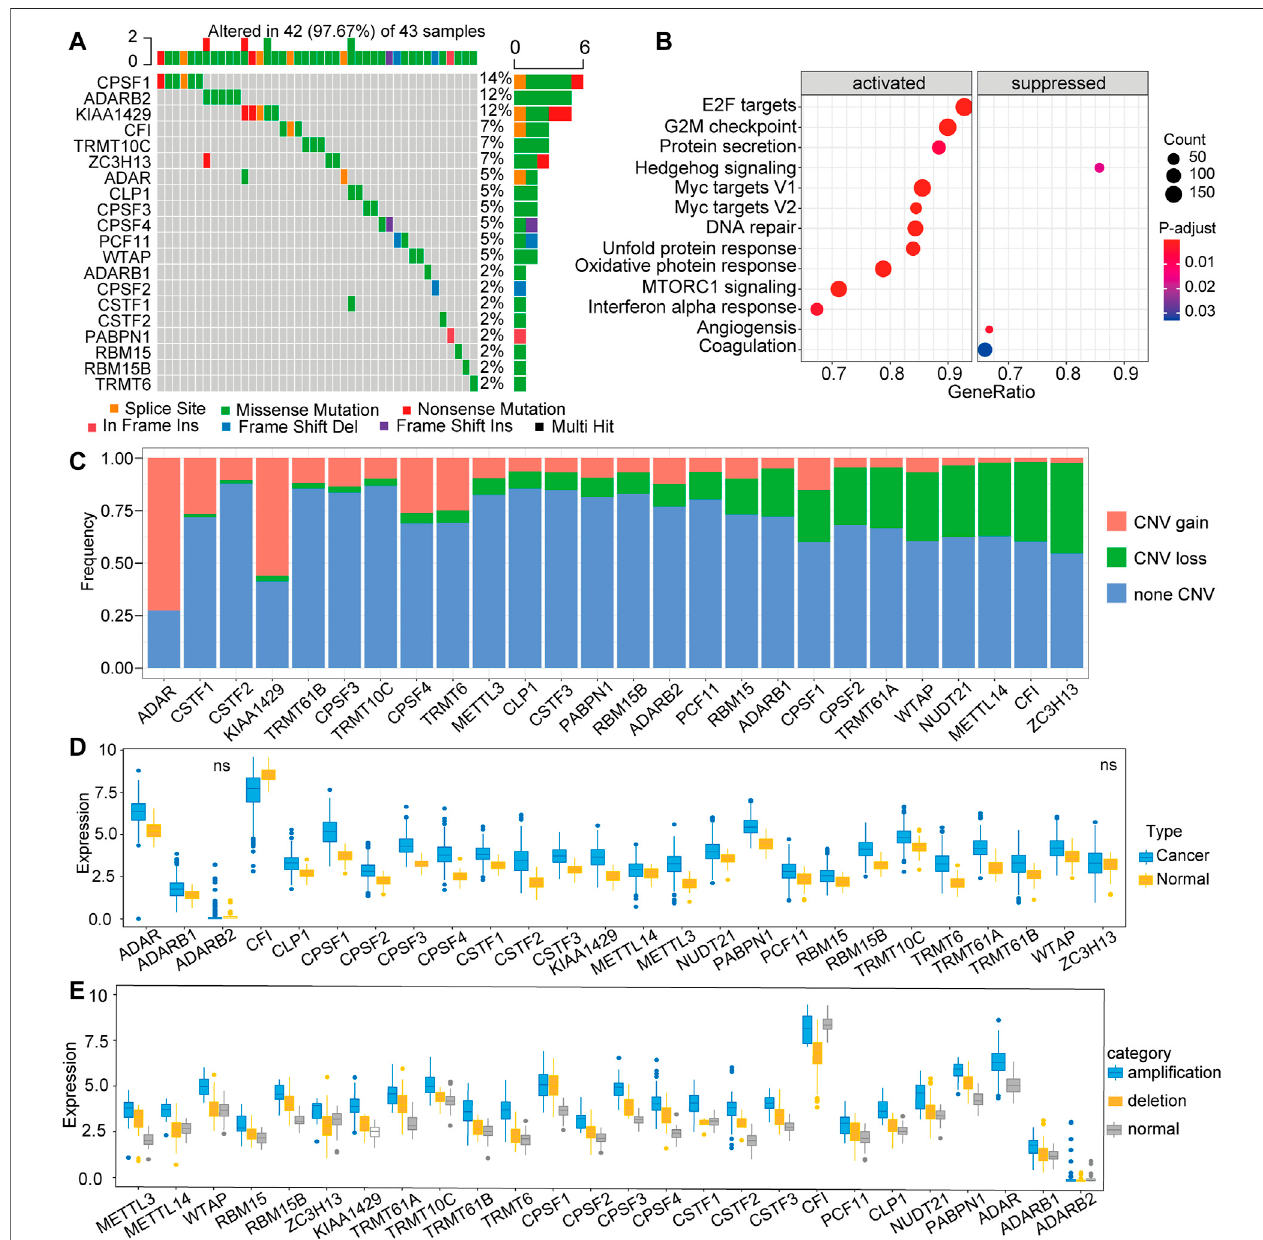
FIGURE 1 | Expression pattern of 26 RNA modi fi cation “ writer ” genes in TCGA-LIHC (A) Frequency of mutations of the 26 identi fi ed regulator genes (B) Gene set variation analysis (GAVA) was used to compare the regulator mutation group and the non-mutation group (C) The CNV mutation frequency of 26 regulator genes in TCGA-LIHC (D) The expression of 26 RNA modi fi cation regulator genes between tumor tissues and control tissues (F) The mRNA expression of “ writer ” among three groups, including ampli fi cation group, CNV deletion group, and normal group.